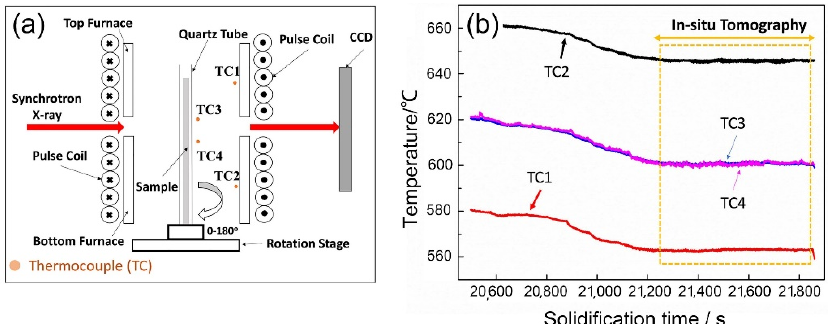
Figure 1. ( a ) A schematic illustration of the experimental setup. ( b ) The measured temperature profiles of TC1, TC2, TC3, and TC4 during the solidification experiments. The framed area is the period during which tomography scans were performed.